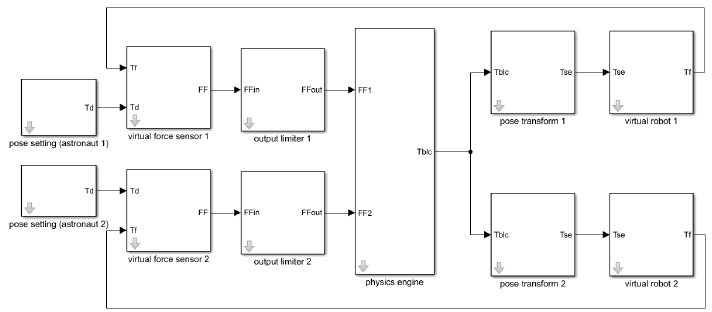
Figure 9. The simulation model of two people cooperatively carrying objects.